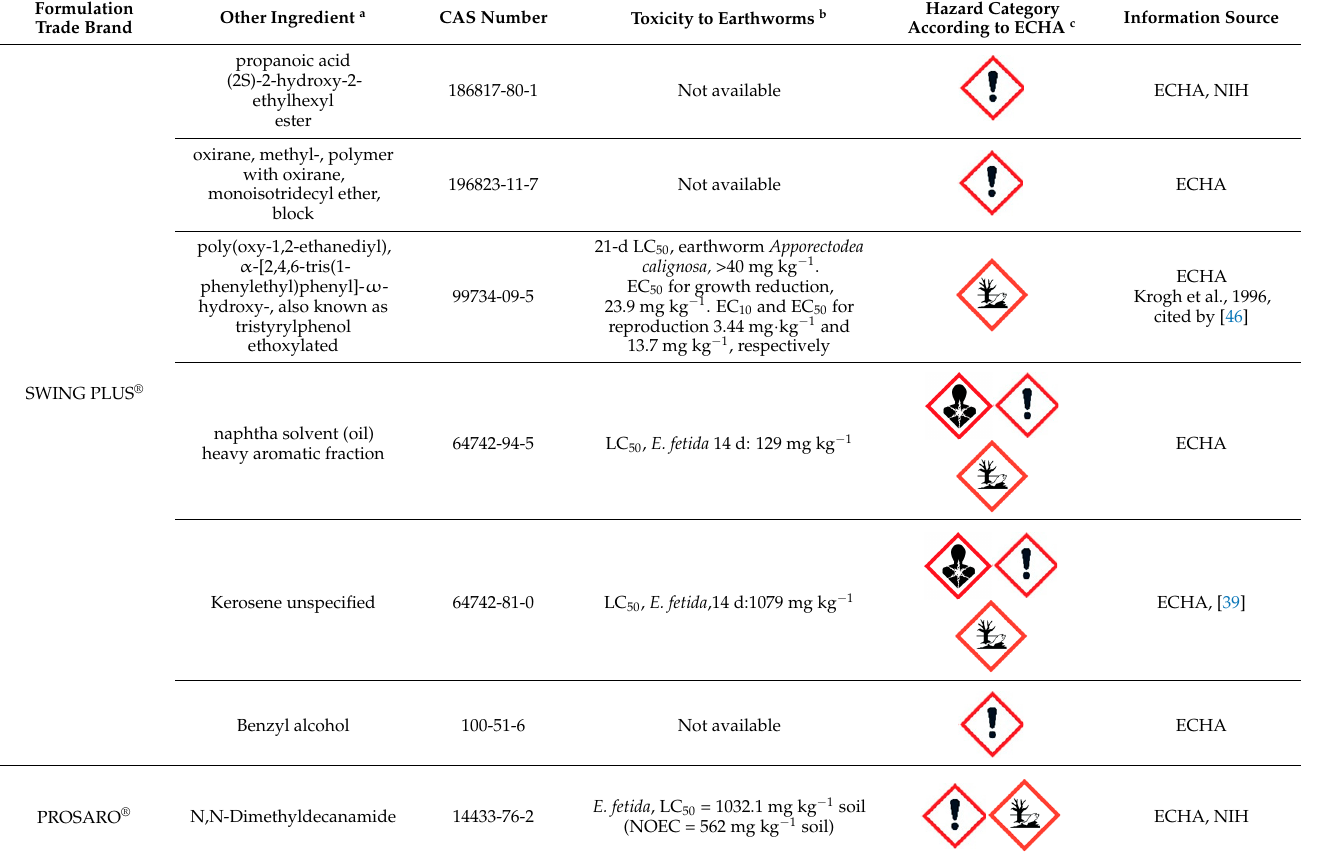
Table 4. The hazards of other ingredients declared in two commercial fungicide